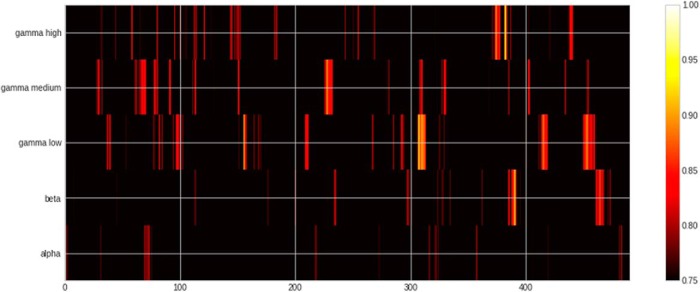
Heatmap of ROC-AUC scores for all bands in lexical condition. Note that chance in this condition is 75%. Time is relative to DP.